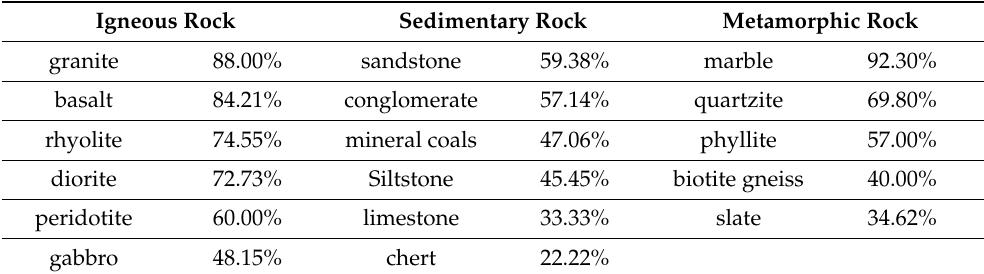
Table 3. Percentage of correct answers in the rock identification.